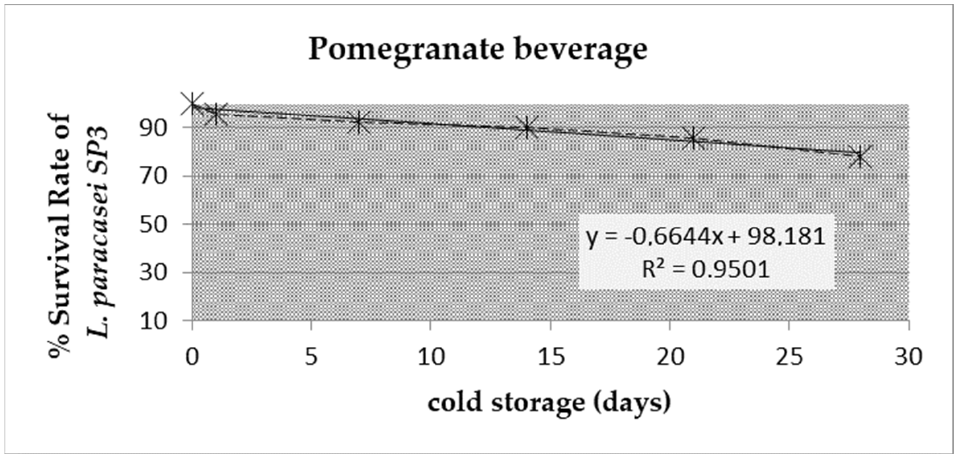
Figure 2. Survival rate (SR %) of the starter culture ( L. paracasei SP3) after manufacture and during cold storage (4 °C) for 28 days.